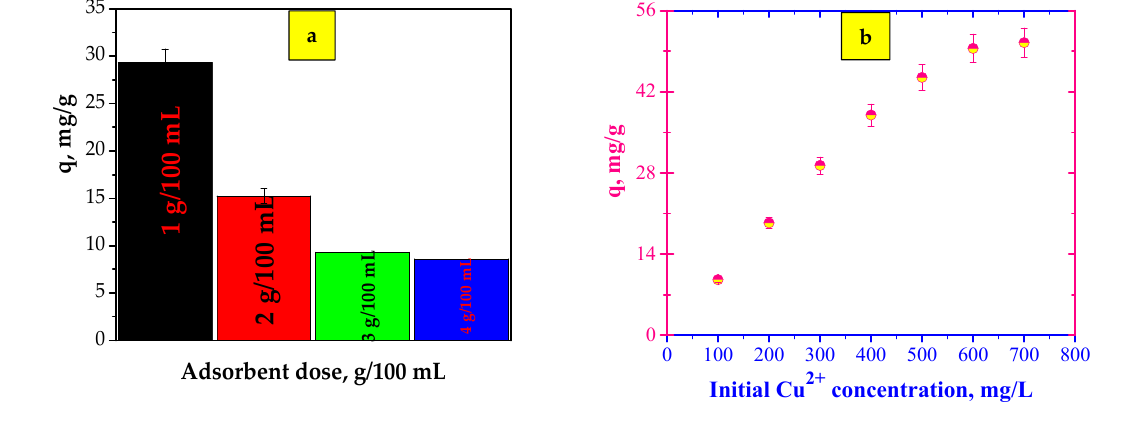
1 g/100 mL; temperature, 25 ◦ C).